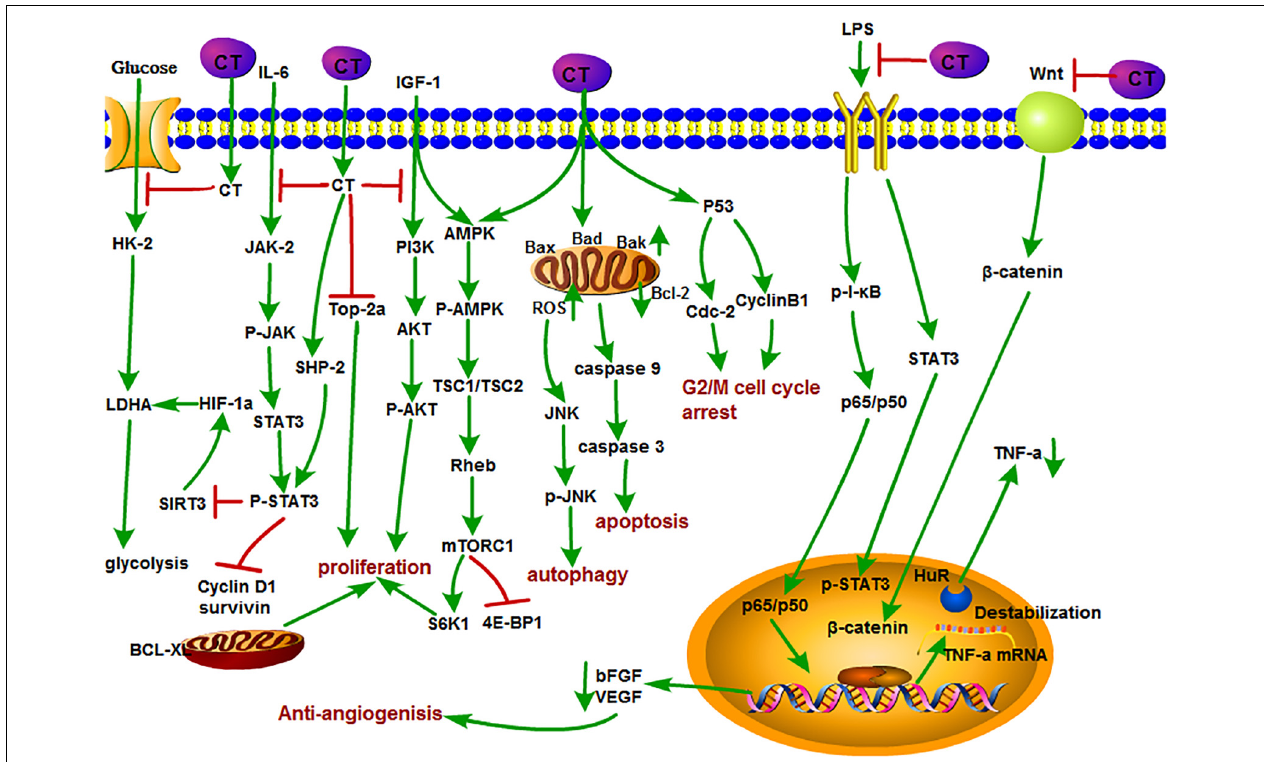
FIGURE 3 | The antitumor mechanism of CT. Cryptotanshinone inhibits the proliferation of cancer cells and induces autophagy and apoptosis by inhibiting IGF-1, IL-6, and glycolysis and mediating the cell cycle and mitochondrial pathway and inhibits angiogenesis by inhibiting the LPS/Wnt signaling pathway. The arrow represents the promotion effect, and the T area represents the inhibition